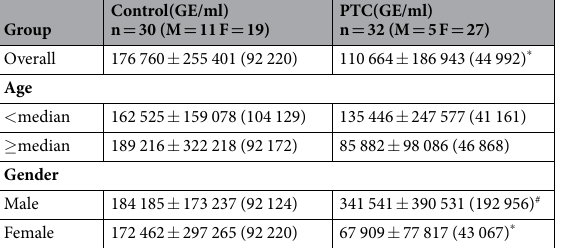
Table 2. Levels of cf-mtDNA in study groups. Data are expressed as mean ± standard deviation (median). GE- genome equivalents. * Statistically significant data corresponding control p ≤ 0.05. # Statistically significant data corresponding female subgroup, p ≤ 0.05.